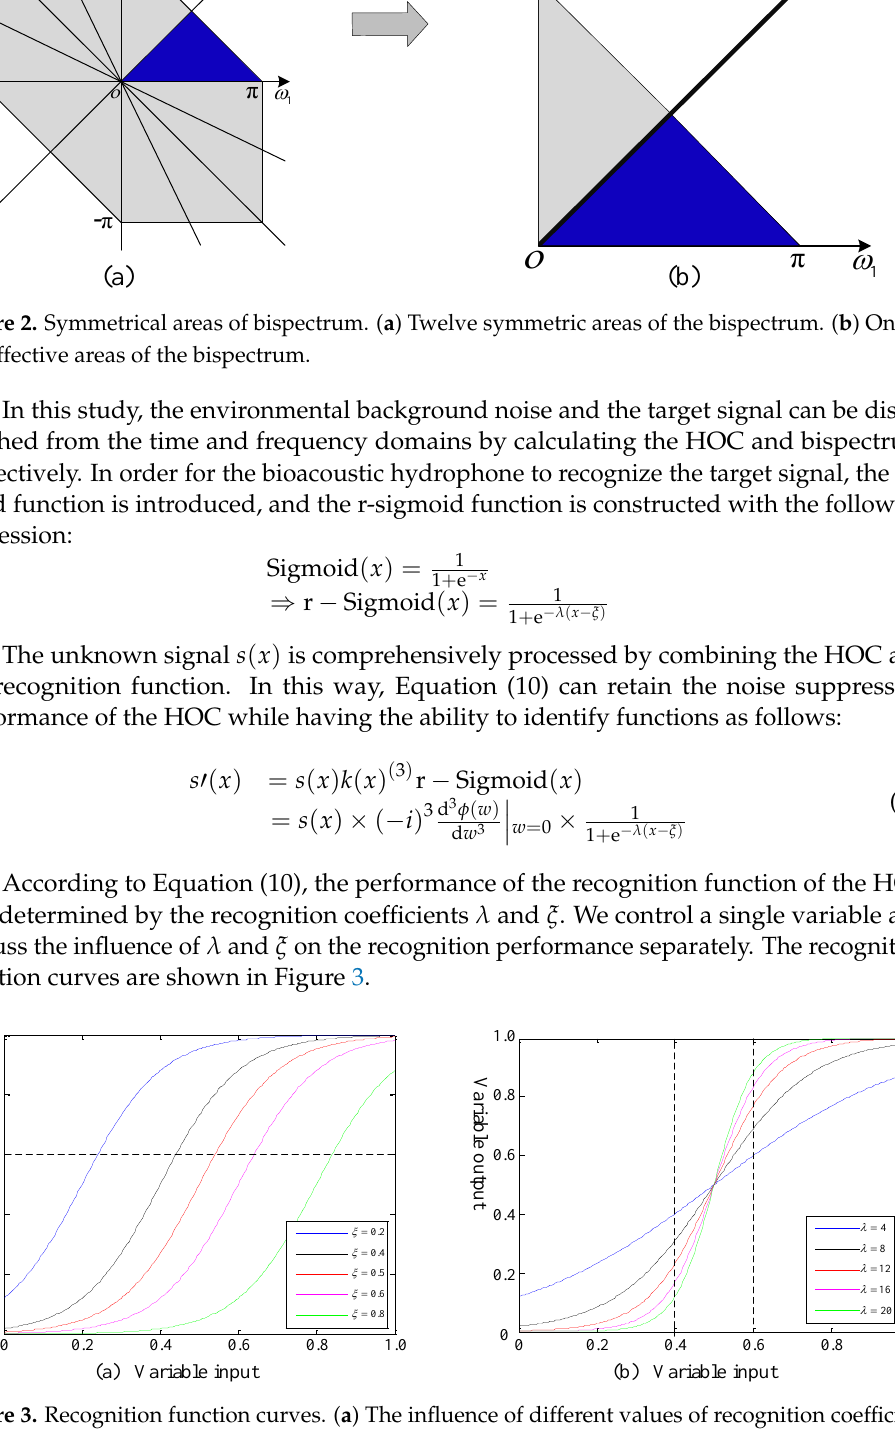
Figure 3. Recognition function curves. ( a ) The influence of different values of recognition coefficient ξ on the curve, when λ = 12. ( b ) The influence of different values of recognition coefficient λ on the curve, when ξ = 0.5.